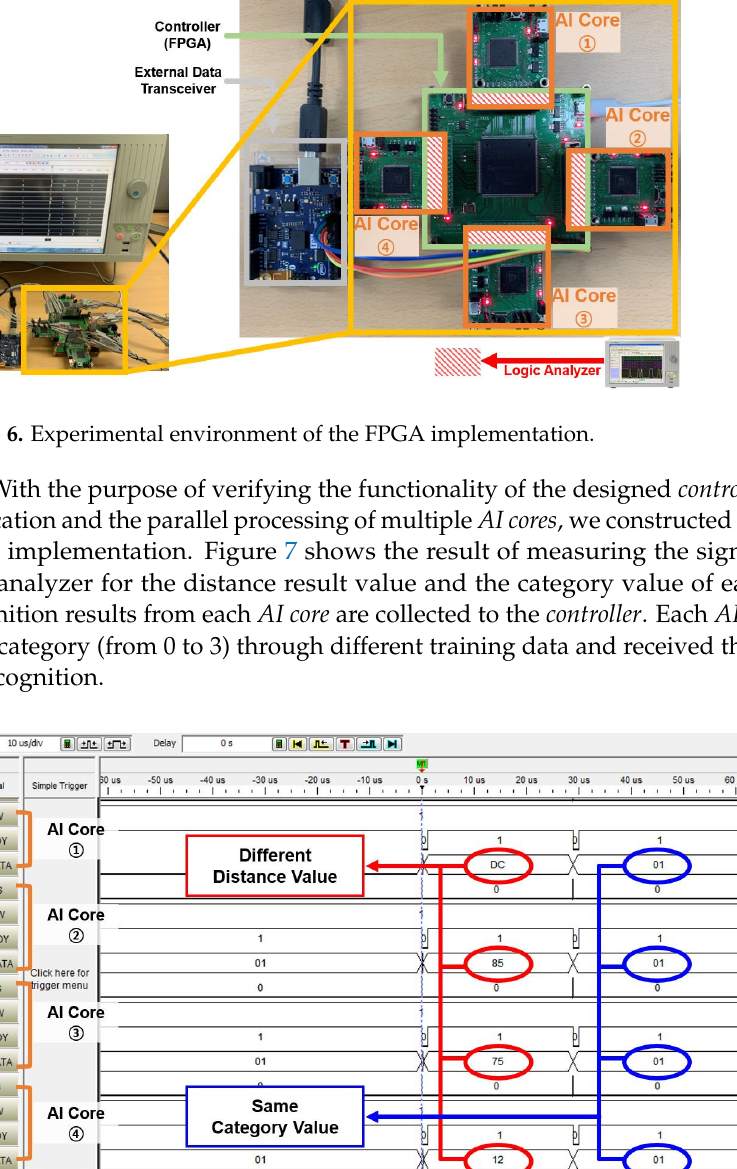
Figure 6. Experimental environment of the FPGA implementation .